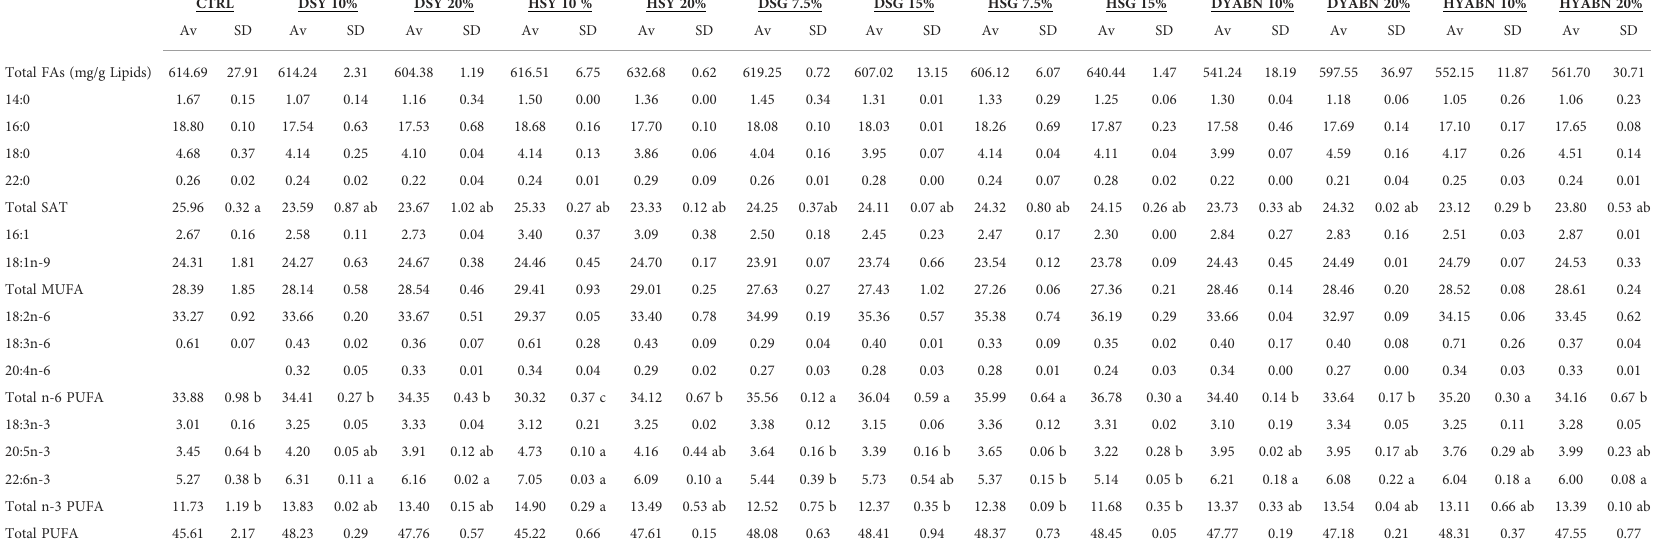
TABLE 6 Fatty acid composition (% of total FAs, only main fatty acids and totals are included) of the feeds used in the trial. CTRL